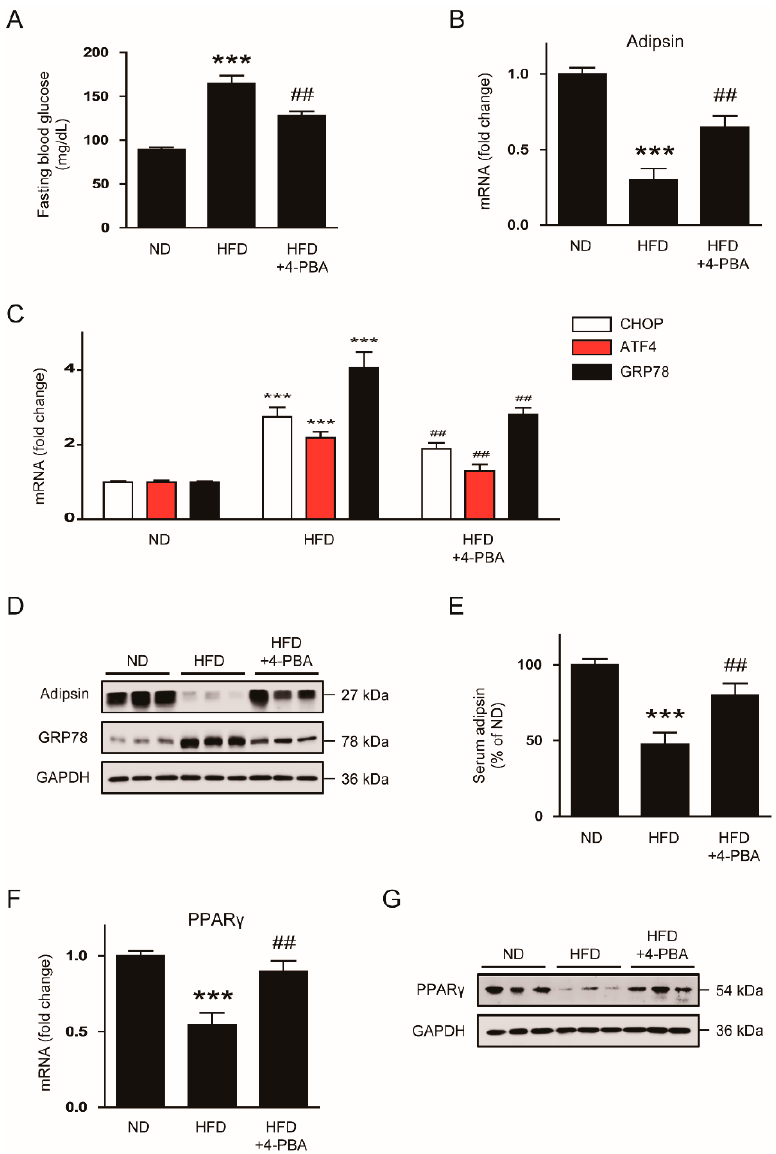
Figure 7. Administration of 4-PBA reverses the ER stress-mediated downregulation of adipsin in vivo. C57BL/6N mice were divided into two groups fed either a normal chow diet (ND; n = 8) or a high-fat diet (HFD; n = 16). After 8 weeks, the HFD-fed mice were divided into two sub-groups: an HFD group (n = 8); an HFD plus 4-PBA group (HFD + 4-PBA; n = 8). The HFD group and the HFD + 4-PBA group were fed with an HFD and intraperitoneally administered with vehicle (phosphate-buffered saline) or 4-PBA (1 g/kg per day) once daily for an additional 4 weeks, respectively. The ND group continued to receive an ND throughout the entire experimental period. After 4 weeks of treatment, all mice were sacrificed. ( A ) Fasting blood glucose levels. ( B ) Real-time RT-PCR analysis of adipsin in gWATs. ( C ) Real-time RT-PCR analysis of CHOP, ATF4, and GRP78 in gWATs. ( D ) Western blot analysis of adipsin, GRP78, and GAPDH in gWATs. GAPDH was used as a loading control. Each lane represents an individual animal. ( E ) Serum levels of circulating adipsin. ( F ) Real-time RT-PCR analysis of PPAR γ in gWATs. ( G ) Western blot analysis of PPAR γ and GAPDH in gWATs. GAPDH was used as a loading control. Each lane represents an individual animal. All data are represented as the mean ± SEM. *** p < 0.001 vs. ND-fed mice. ## p < 0.01 vs. HFD-fed mice.